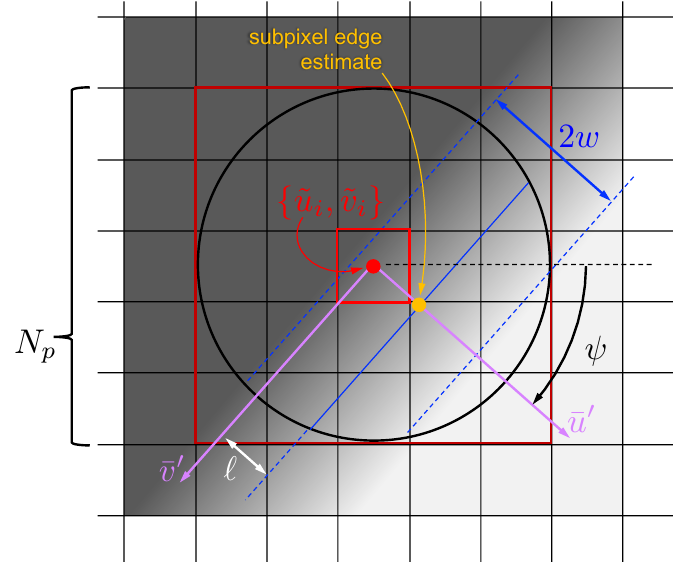
Figure 1. Example geometry of a square image patch ( N p = 5, shown in dark red) centered about ˜ u i , ˜ v i pixel-level edge guess shown in bright red. The edge has a blur width of 2 w and is offset from { } the pixel-level guess by a distance (cid:96) . The primed frame (rotated by an angle ψ relative to the unprimed image frame) is aligned with the edge, with ¯ v (cid:48) being parallel to the edge and ¯ u (cid:48) being normal to the edge. Although this figure shows only an edge, these coordinate frame conventions are the same for both edges and